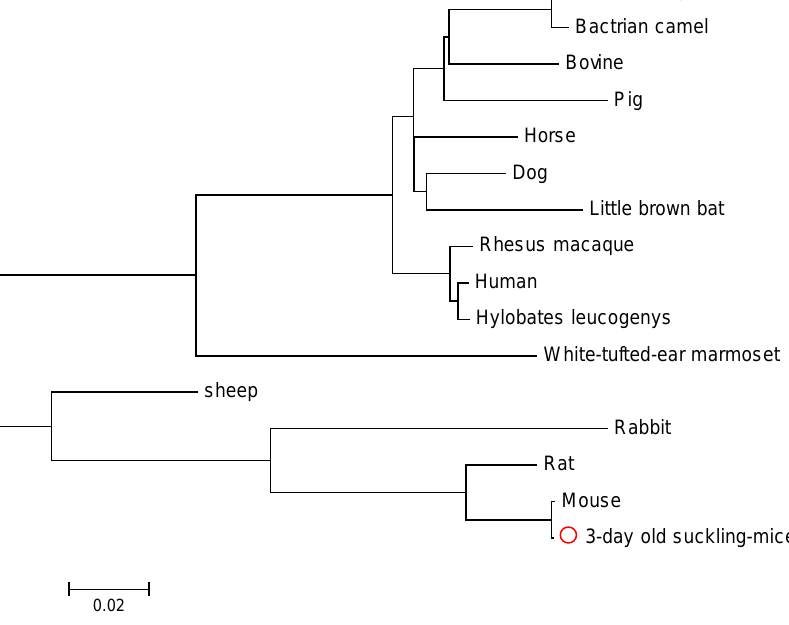
Figure 1. Phylogenetic tree of suckling mouse integrin β 6 subunit. The phylogenetic tree was constructed based on the nucleotide sequences, using the neighbor-joining algorithm of MEGA version 5.05. The reference sequences included in the analysis were taken from